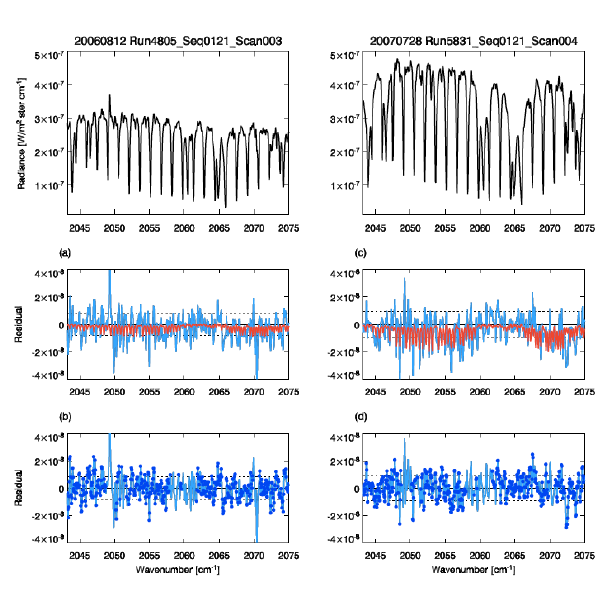
Fig. 4. Carbonyl sulfide spectral signal in the TES observations. The top two panels are the TES measured spectra for OCS retrievals. In (a) and (c), light blue lines without dots ( d1 ) are the differences between TES measured spectra and forward-­‐ model run driven by retrieved CO2 and H2O but no OCS; red lines ( d2 ) are differences between two forward-­‐model runs with and without OCS or can be considered as OCS vertivally integral Jacobians. In (b) and (d) shown in light blue lines with dots ( d3 ) are the residuals after OCS retrieval. Dots indicate the frequencies of the channels used for retrieval. Solid black lines are the zero lines and dashed lines represent the noise level (NESR).